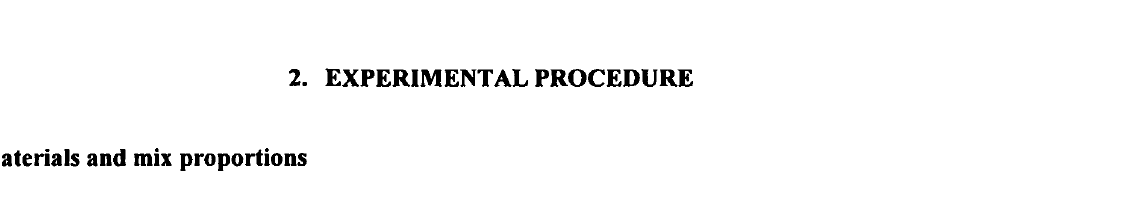
The mineral composition of the used types of cement clinker (Bogue).